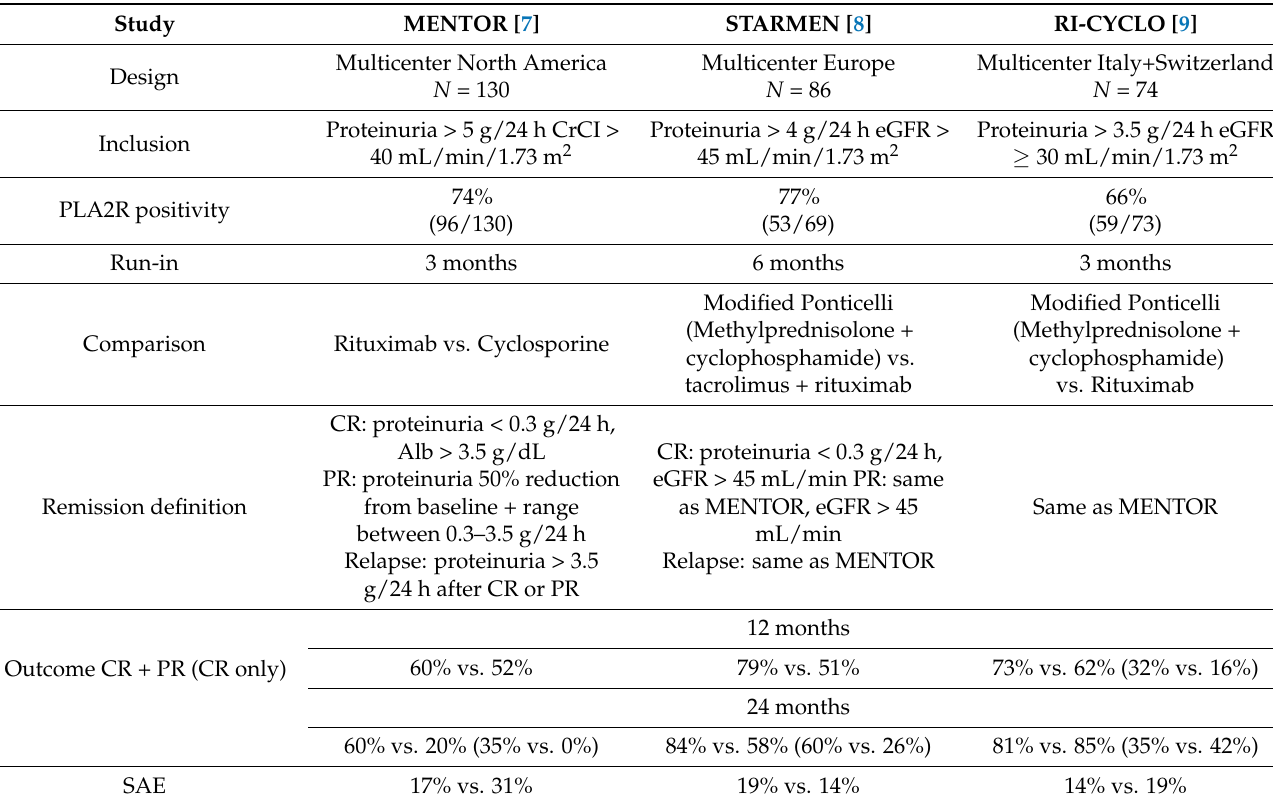
Table 1. Major randomized clinical trials (RCTs) on membranous nephropathy since